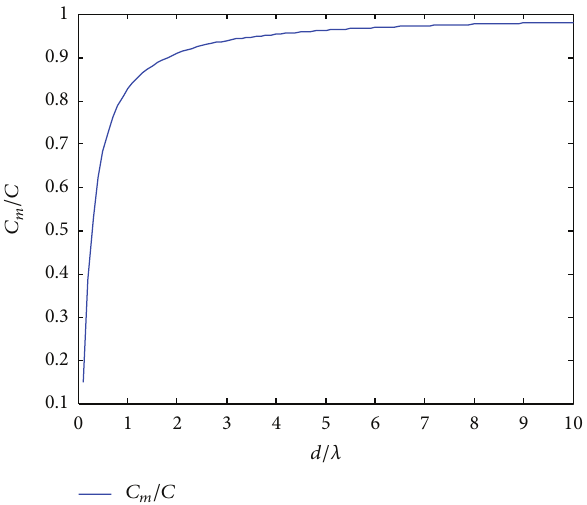
Figure 6: The relationship between the improved and conventional shock factors.